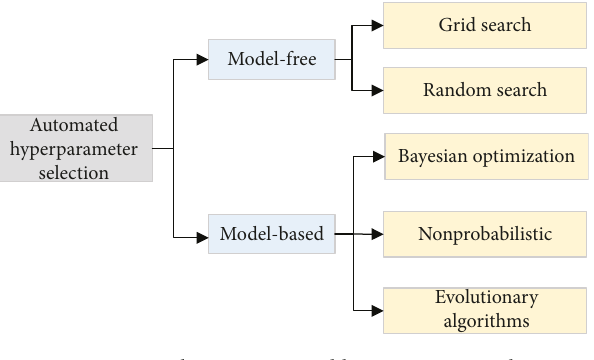
Figure 6: Approaches to automated hyperparameter